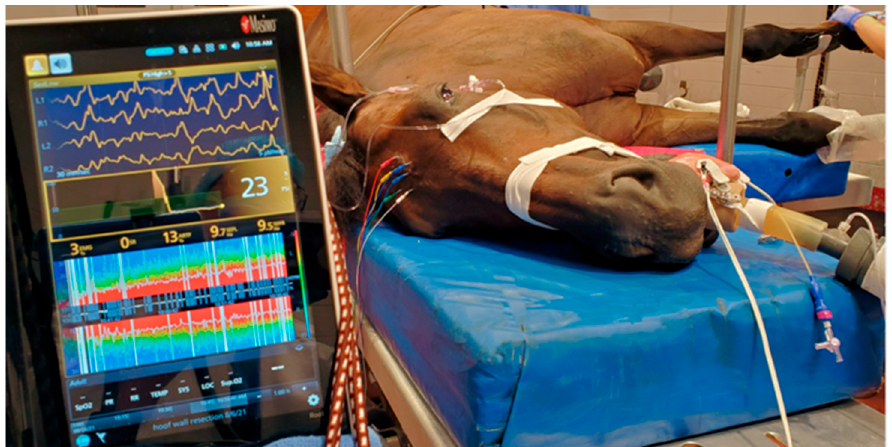
Figure 2. A Sedline ® monitor with needle electrodes connected to the forehead of a horse anesthetized with isoflurane while being prepared for surgery. The Sedline ® monitor shows a PSI of 23, the trend of the PSI over the last 20 minutes, and the 4-channel raw EEG waveforms at the top of the monitor. The SEF 95 on the left hemisphere is 9.7 Hz and 9.5 Hz on the right hemisphere. The suppression ratio is zero, and the artifact % is 3.